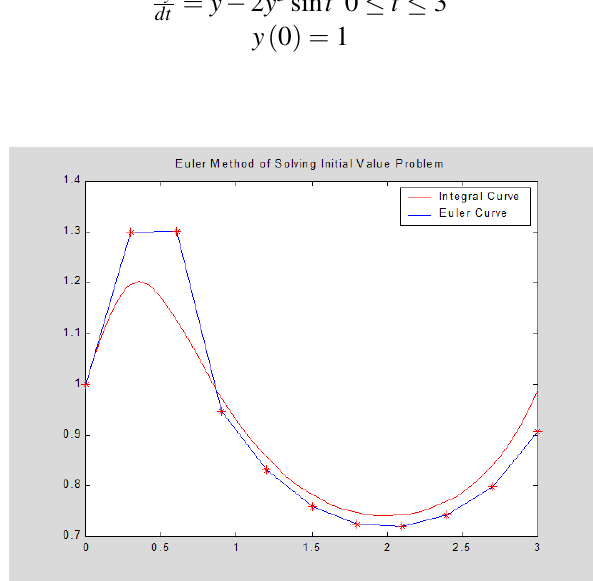
Fig. 1 Numerical solution based on the Euler method.